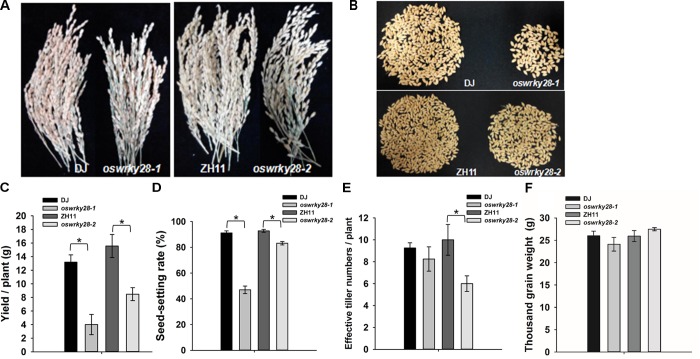
Agronomic trait comparison of the wild-type and oswrky28 mutants in the soil pot experiment. (A) Comparison of the spikelets of wild-type and oswrky28 plants. (B,C) Seed yield per plant of wild-type and oswrky28. (D) Seed-setting rate; (E) Effective tiller number; (F) Thousand grain weight. Asterisks indicate significantly different at P < 0.05 (Tukey’s test, n = 4).